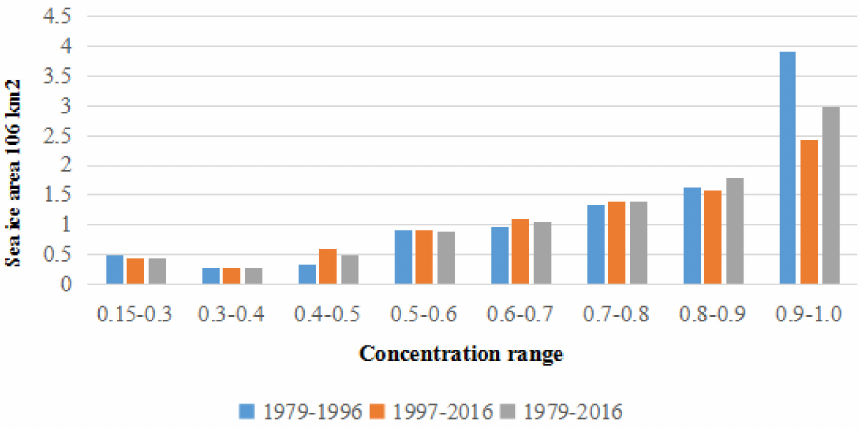
Figure 8. Sea ice area in different ranges